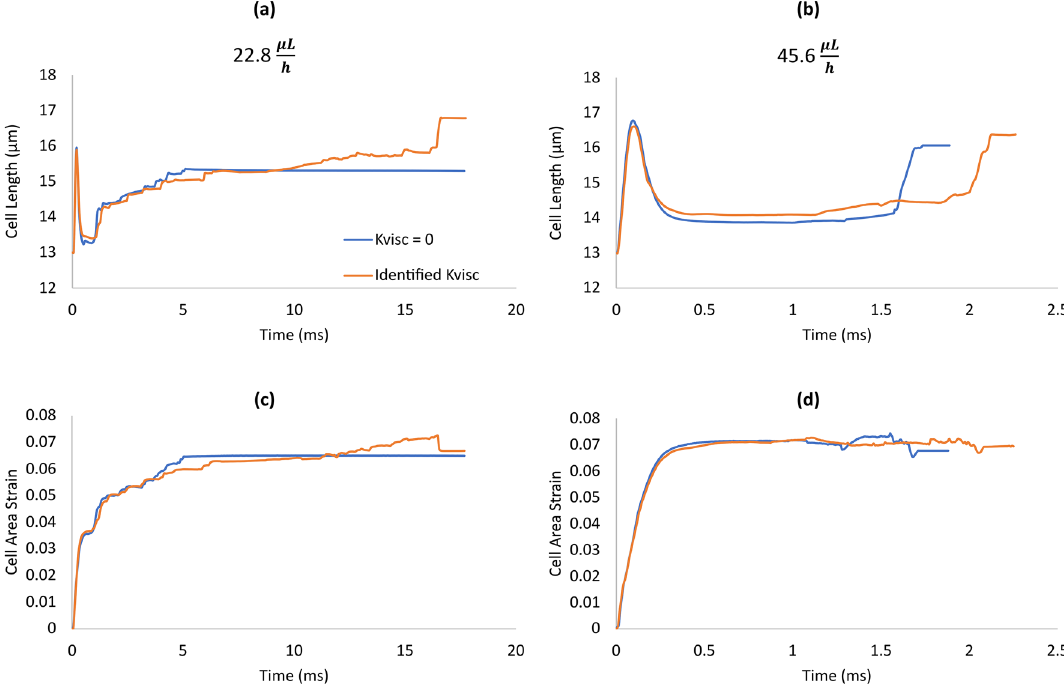
Figure 5. Effects of membrane viscosity on cancer-cell deformation in constriction at two flow rates. ( a , c ) evolutions of the cell length and area strain at 22.8 µL/h, ( b , d ) evolutions of the cell length and area strain at 45.6 µL/h. The area strain is defined as the change in the cell area relative to its undeformed shape divided by its undeformed initial area. Membrane viscosity had flow-rate dependent effects of the motion and deformation of the cell. Neglecting the viscosity caused overestimation and underestimation of the entry time to the constriction at the low and high flow rates,